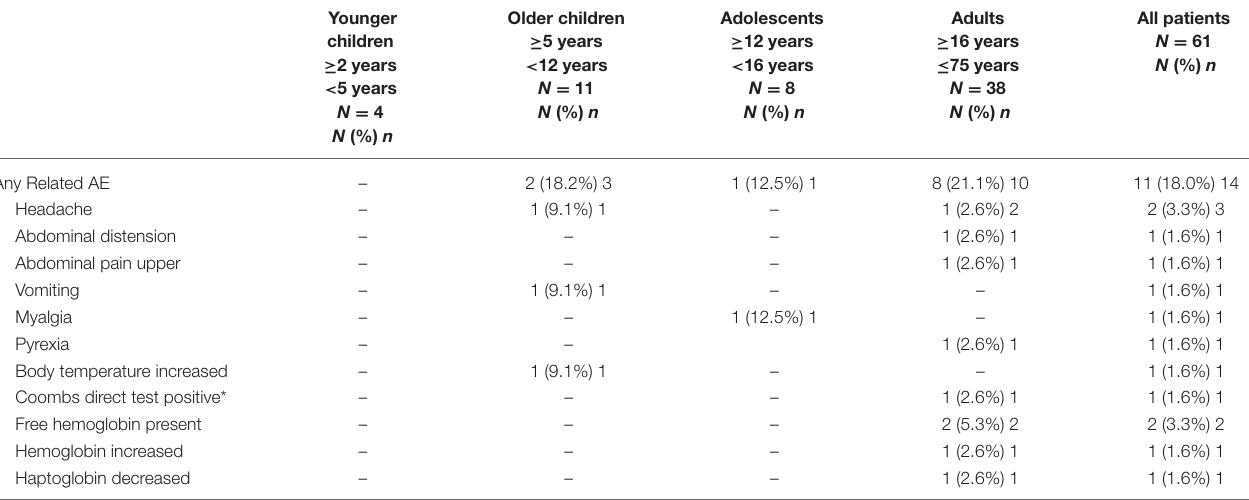
TABLE 5 | Related adverse events (excluding infections and infusion site